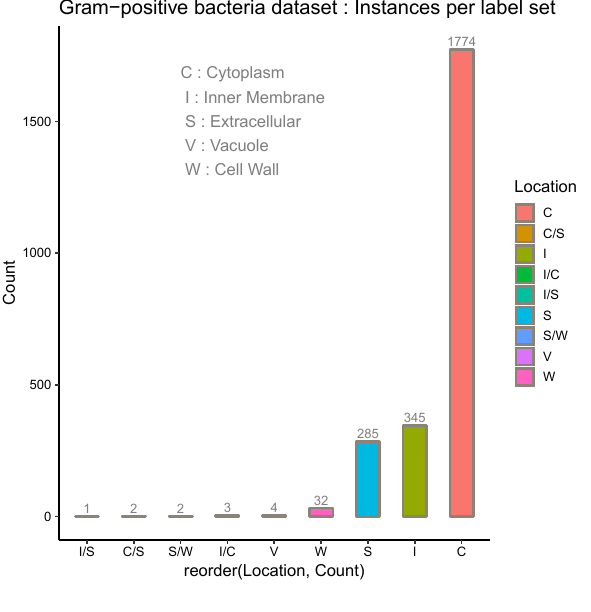
Figure 5: Observed localization sites of proteins in Gram- positive bacteria